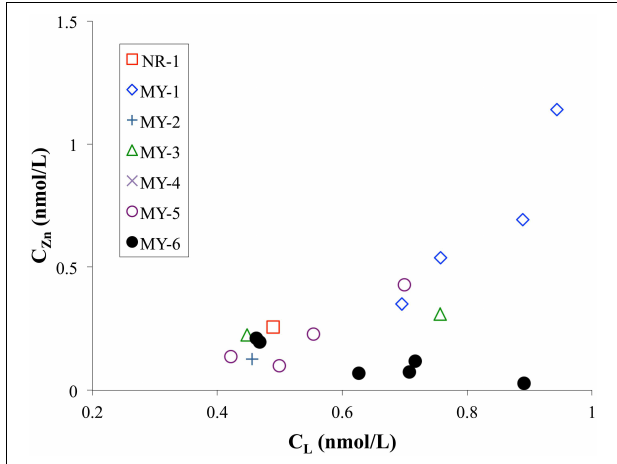
FIGURE 7 | Comparison of C L and C Zn in the northeastern Indian Ocean (NR-1) and the Andaman Sea (MY-1–MY-6).